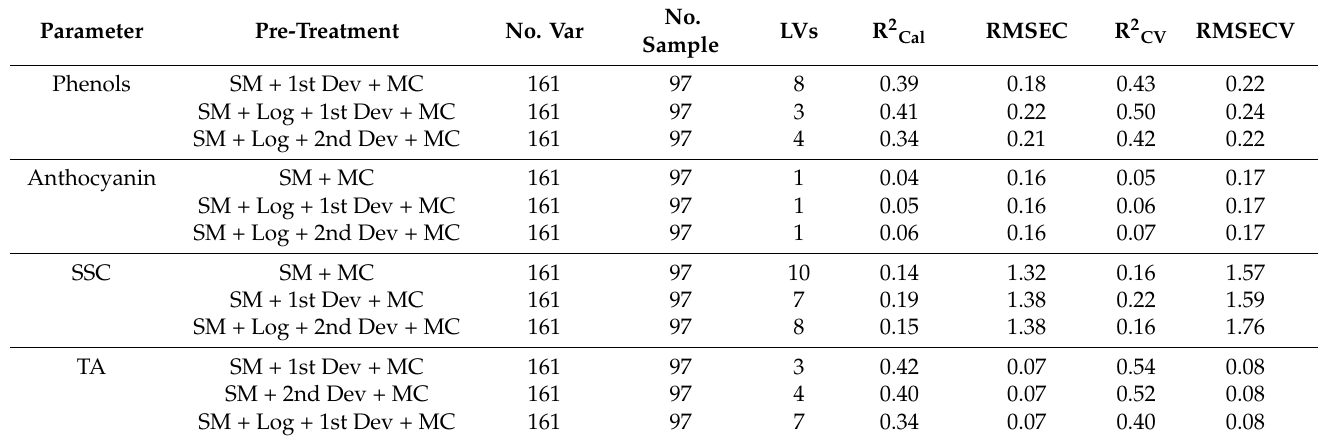
Table 4. Prediction statistics for the best PLSR models of the internal constituents of fresh goji berries in the VIS-NIR